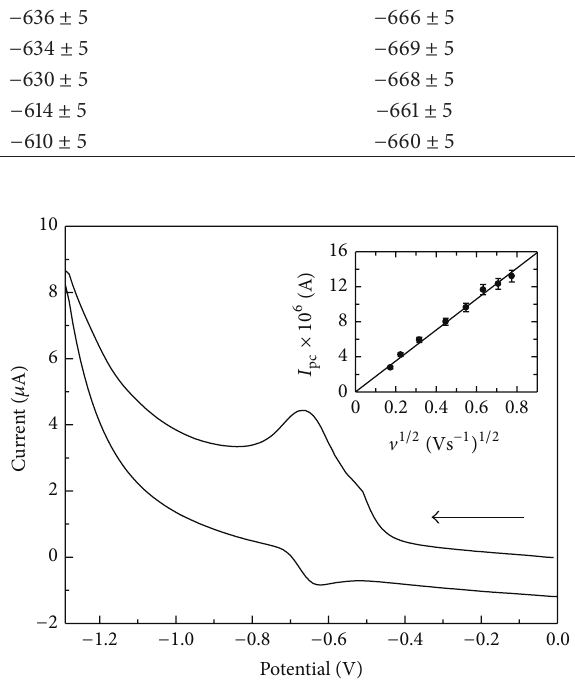
Figure 1: Cyclic voltammogram of doxorubicin hydrochloride in aqueous buffer at pH 7.4 on glassy carbon electrode. [Doxorubicin hydrochloride] = 33 𝜇 M, [NaCl] = 0.160M, scan rate = 0.1Vs −1 , and temperature = 25 ∘ C. Inset: plot of cathodic peak current versus square root of scan rate for the two-electron reduction of doxorubicin hydrochloride in aqueous buffer at pH